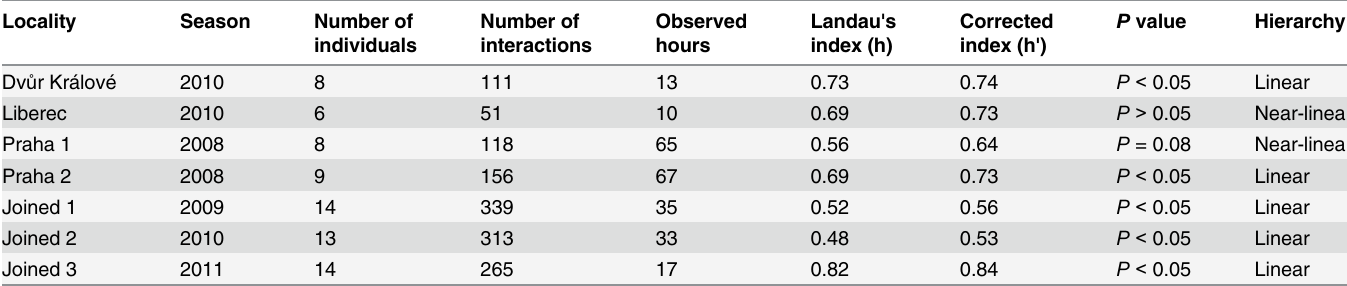
Table 1. Results of linearity in all studied herds.